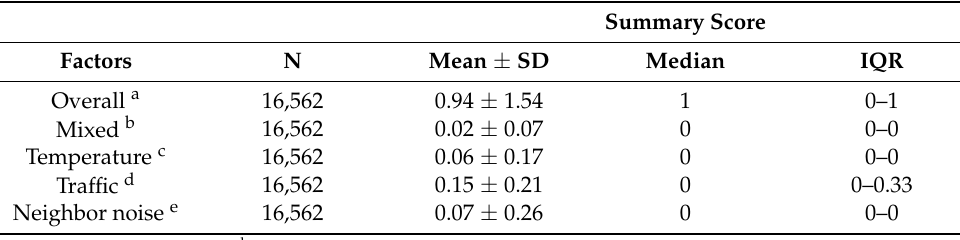
Table 4. Summary score of perceived indoor environment. N =